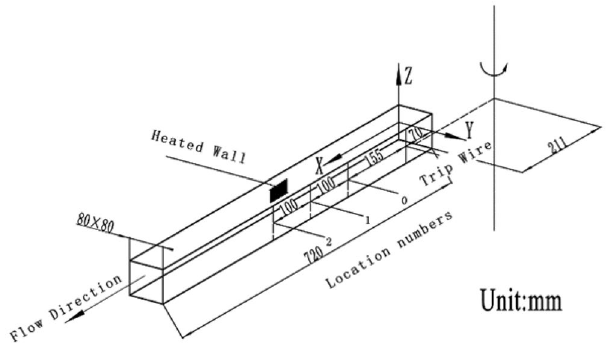
Figure 3. The geometry of the square channel.